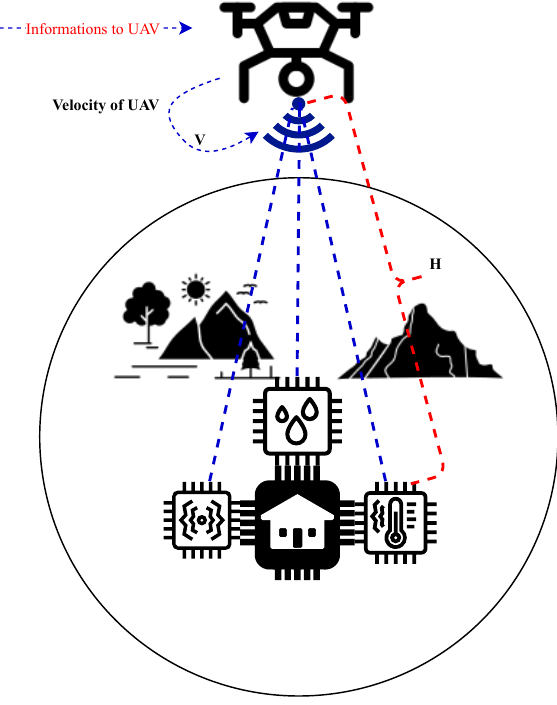
Figure 1. System